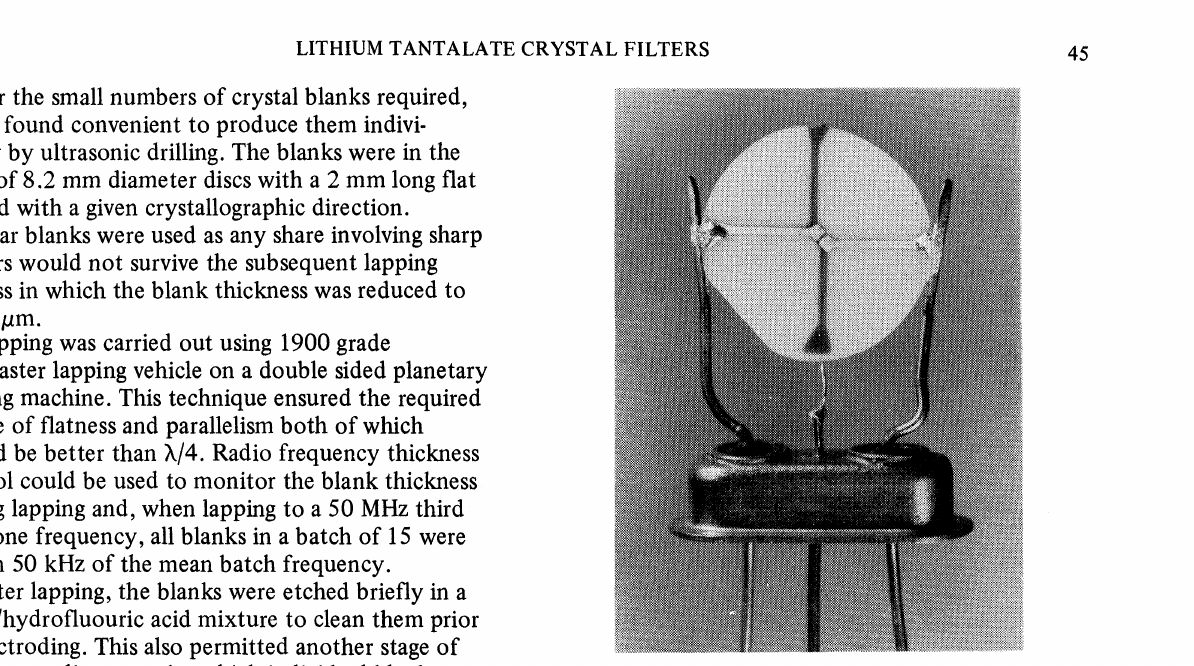
FIGURE 2 Electroded crystal blank mounted in style J holder. Crystal diameter 8.2